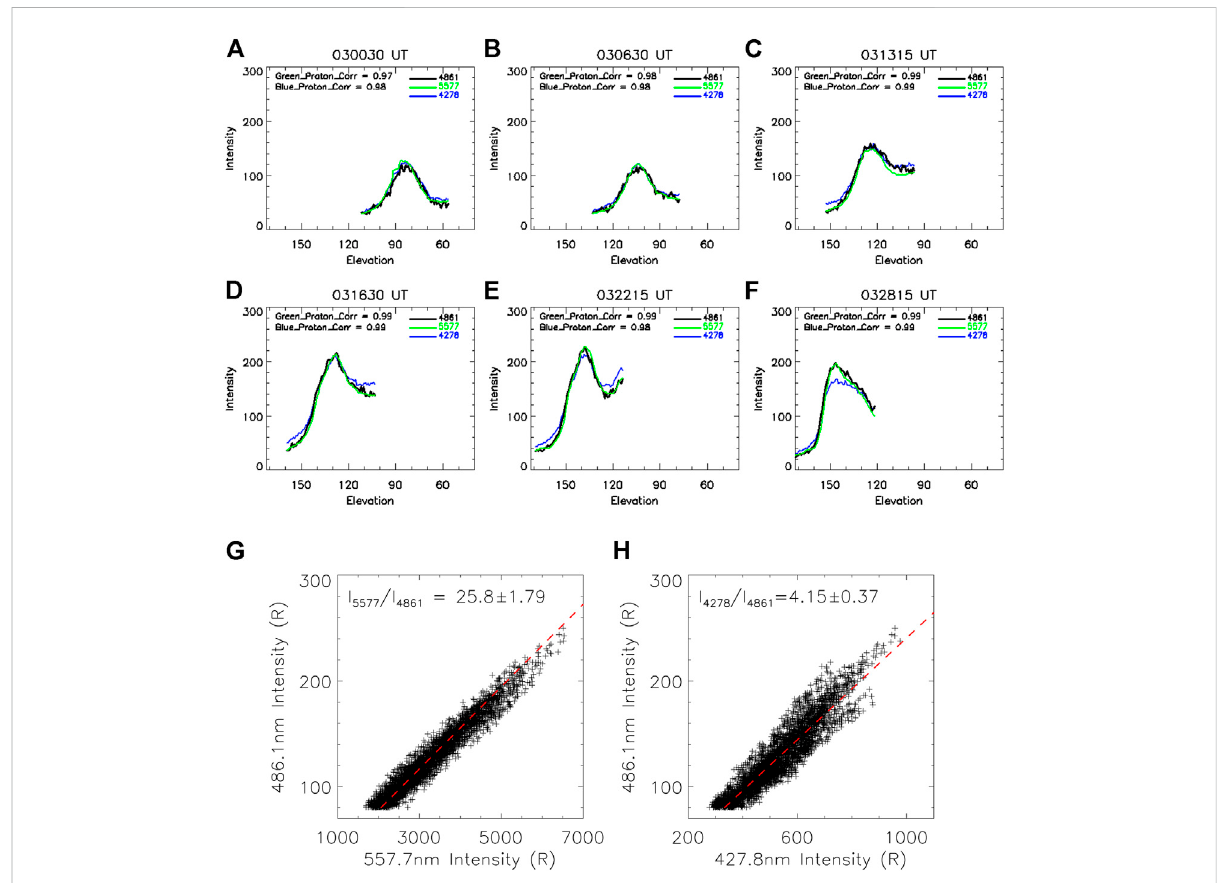
FIGURE 7 (A) – (F) exemplify six time epochs of the comparison and correlation among the elevation-angle structures of 486.1 nm (black), 557.7 nm (green), and 427.8 nm (blue) intensities. The 557.7 nm intensity is scaled by 1/26, while the 427.8 nm intensity is scaled by 1/4, in these plots. (G) The scatter plot of all sampled 557.7 and 486.1 nm emission intensities during the entire IPA interval. (H) The scatter plot of all sampled 427.8 and 486.1 nm emission intensities. The mean and standard deviation of their ratios are given in (G) and (H) for